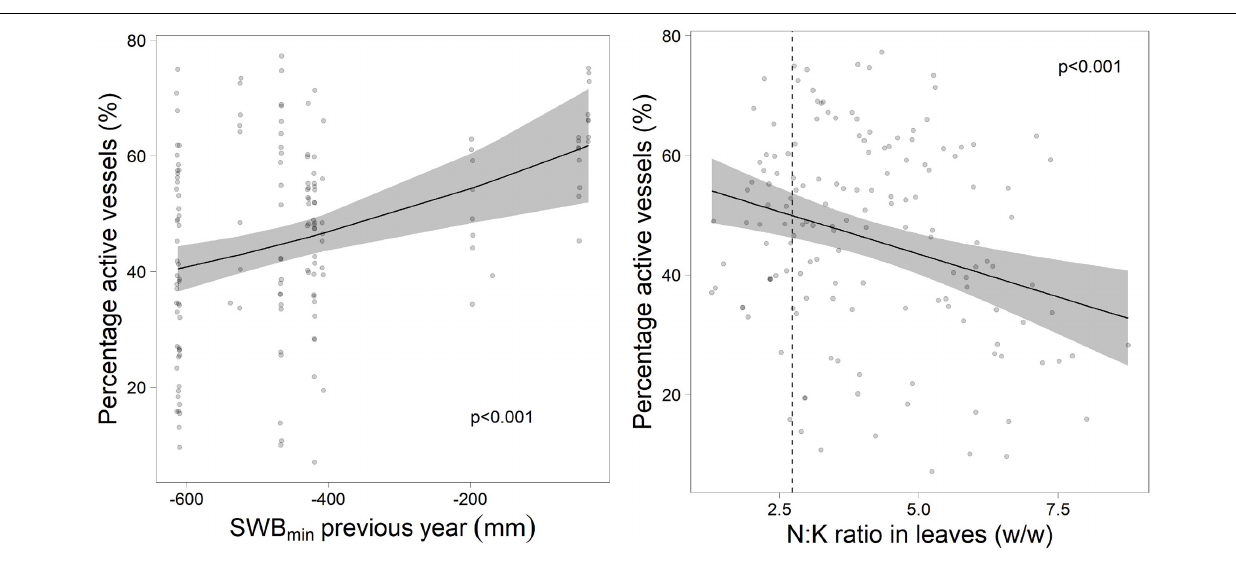
Frontiers in Forests and Global Change |